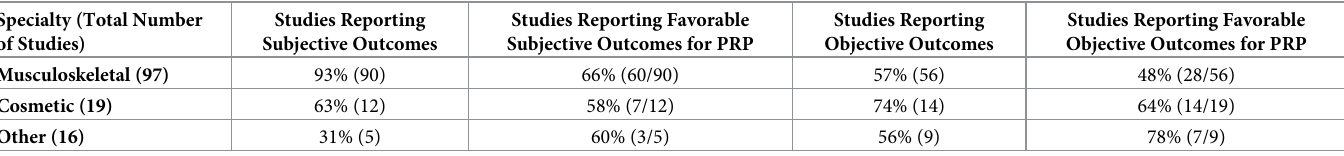
Table 4. Percentage of studies reporting subjective and objective